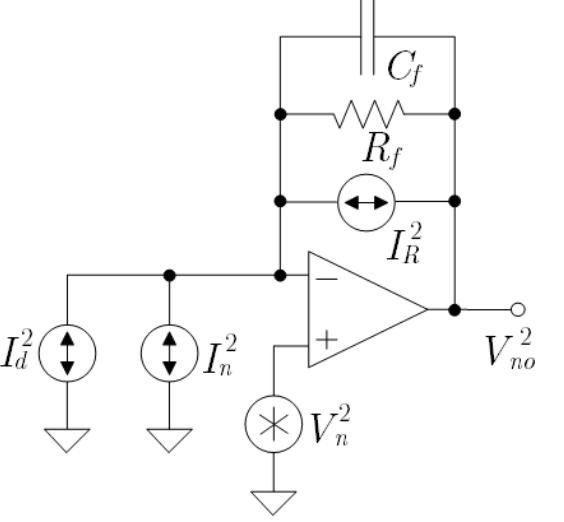
Fig. 7. Noise-equivalent circuit of the